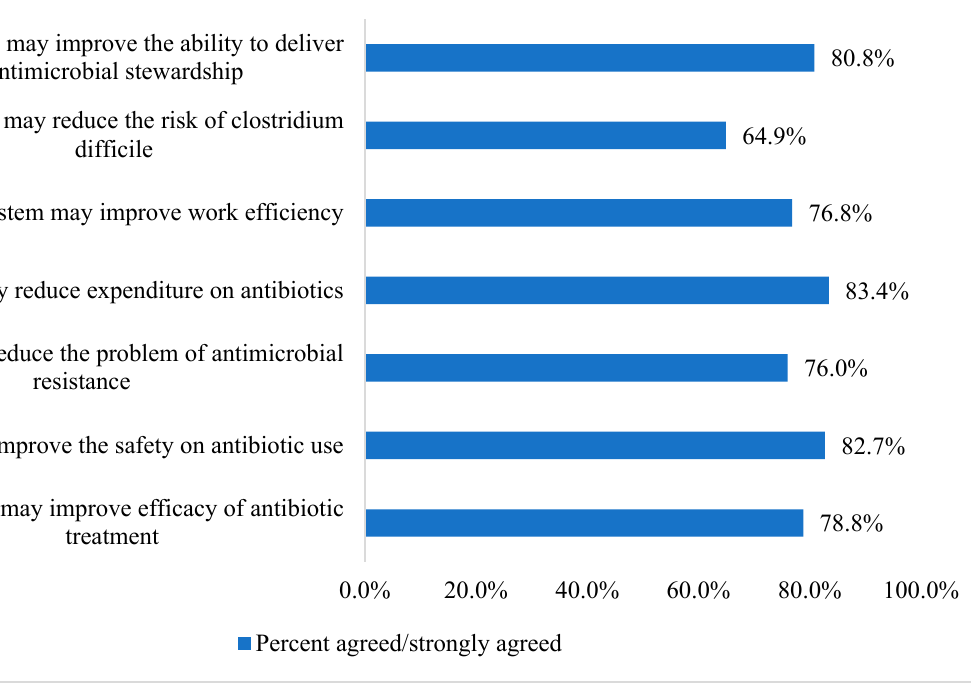
Figure 1. Participants perceived the benefits of using electronic prescribing and electronic health record systems in antimicrobial stewardship ( n = 254).